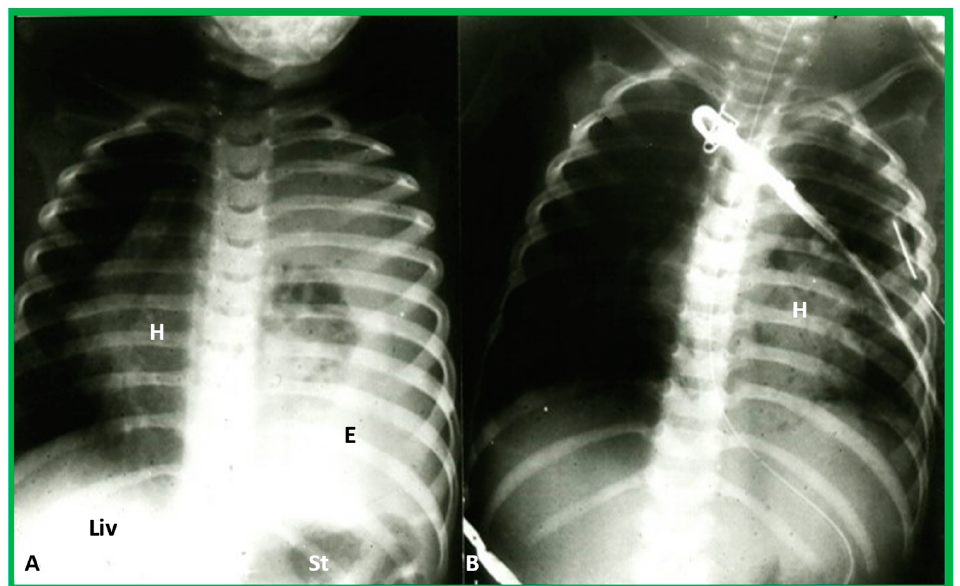
stomach (St) is located on the left side (normal). ( B ) The sternum (arrow) is showing posterior dis- placement, presumably causing dextroposition of the heart. Modified from reference [3].